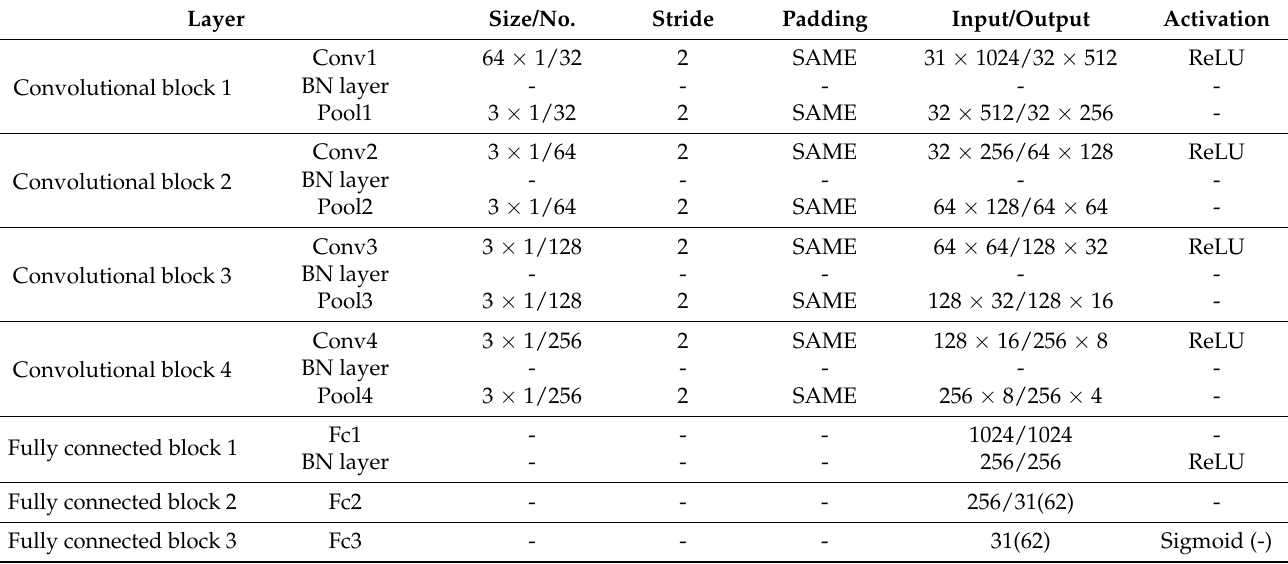
Figure 12. Architecture of the corresponding CNN model. Table 6. Parameters of the corresponding CNN model.